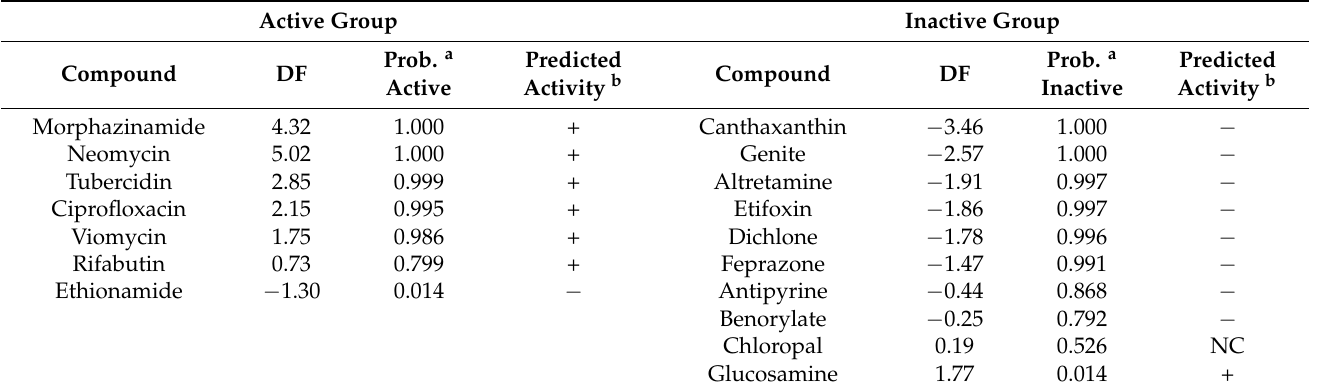
Table 4. Results of the external validation for DF.